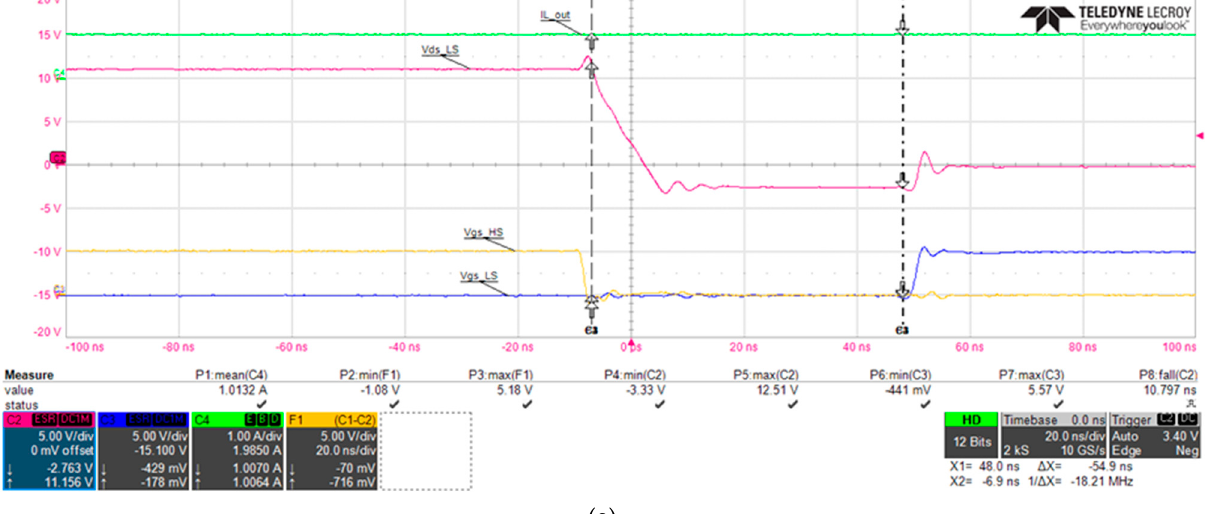
( b ) Figure 31. Switching waveforms of the converter using the monolithic device: ( a ) turn-off, ( b ) turn- on. Figure 32 reports the power transfer efficiency at different load conditions. It is clear that the proposed solution presents a higher efficiency for all load conditions. The highest efficiency (85%) is achieved with a load equal to 10 Ω , while the highest difference between the two solutions is achieved at a load condition of about 5 Ω . Because the application